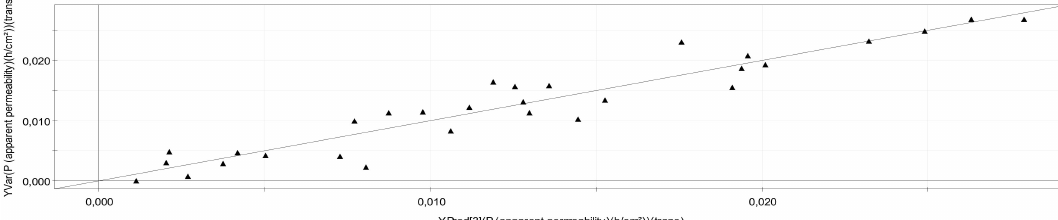
Figure 1. Observed versus estimated values of model P app with apparent permeability values as ( Y ) variable, RMSEE = 0.00265379.